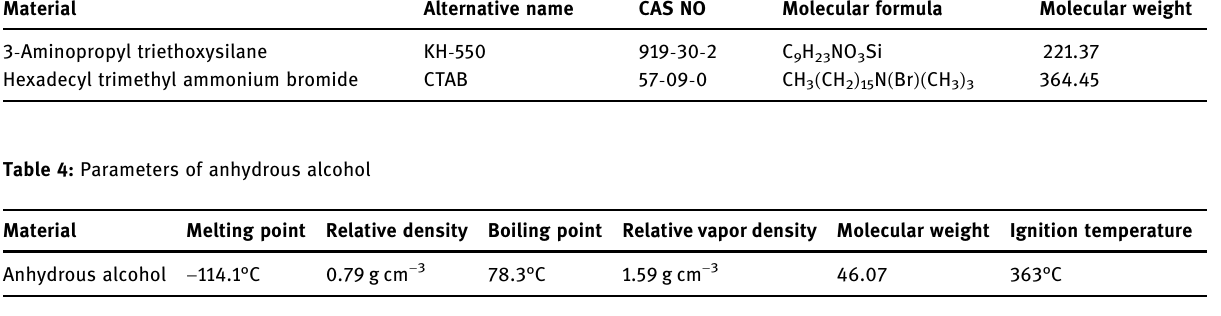
Table 3: Parameters of surface modi fi er Material